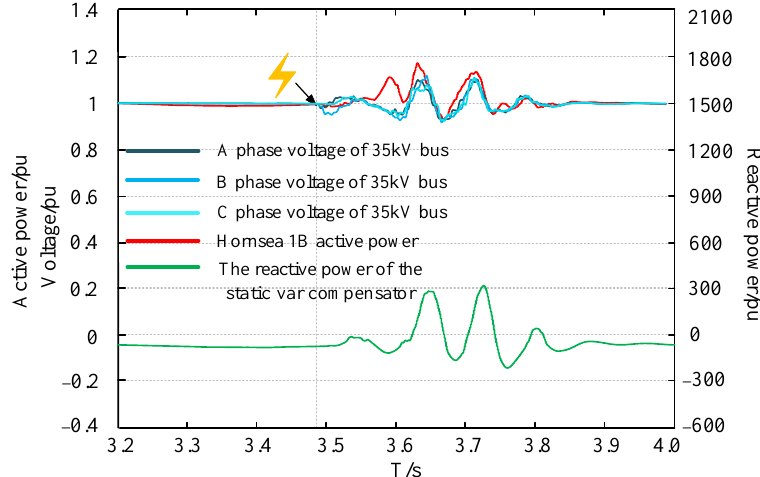
Figure 9. Response of Hornsea wind farm under improved control.